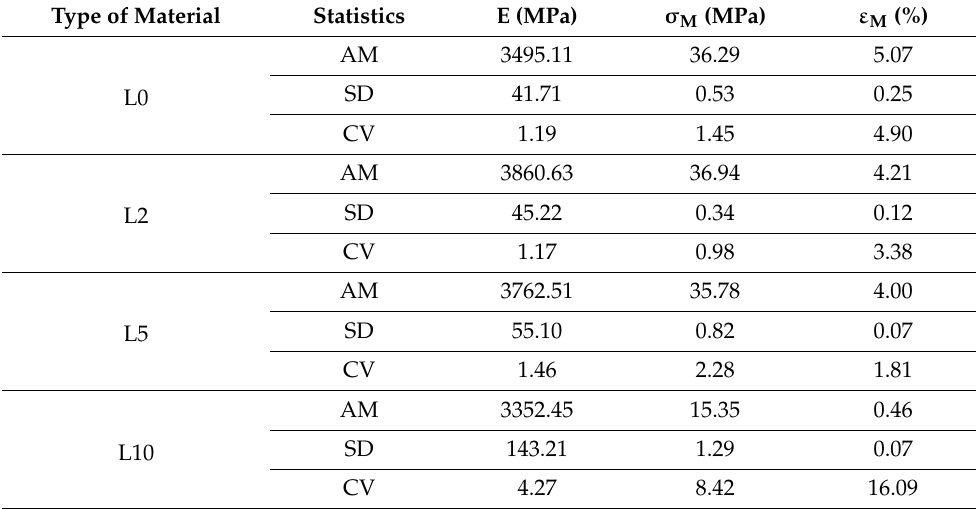
Table 5. Results from the uniaxial tensile test for biocomposites with unmodified flax fibers and exposed to: 2%, 5% and 10% NaOH